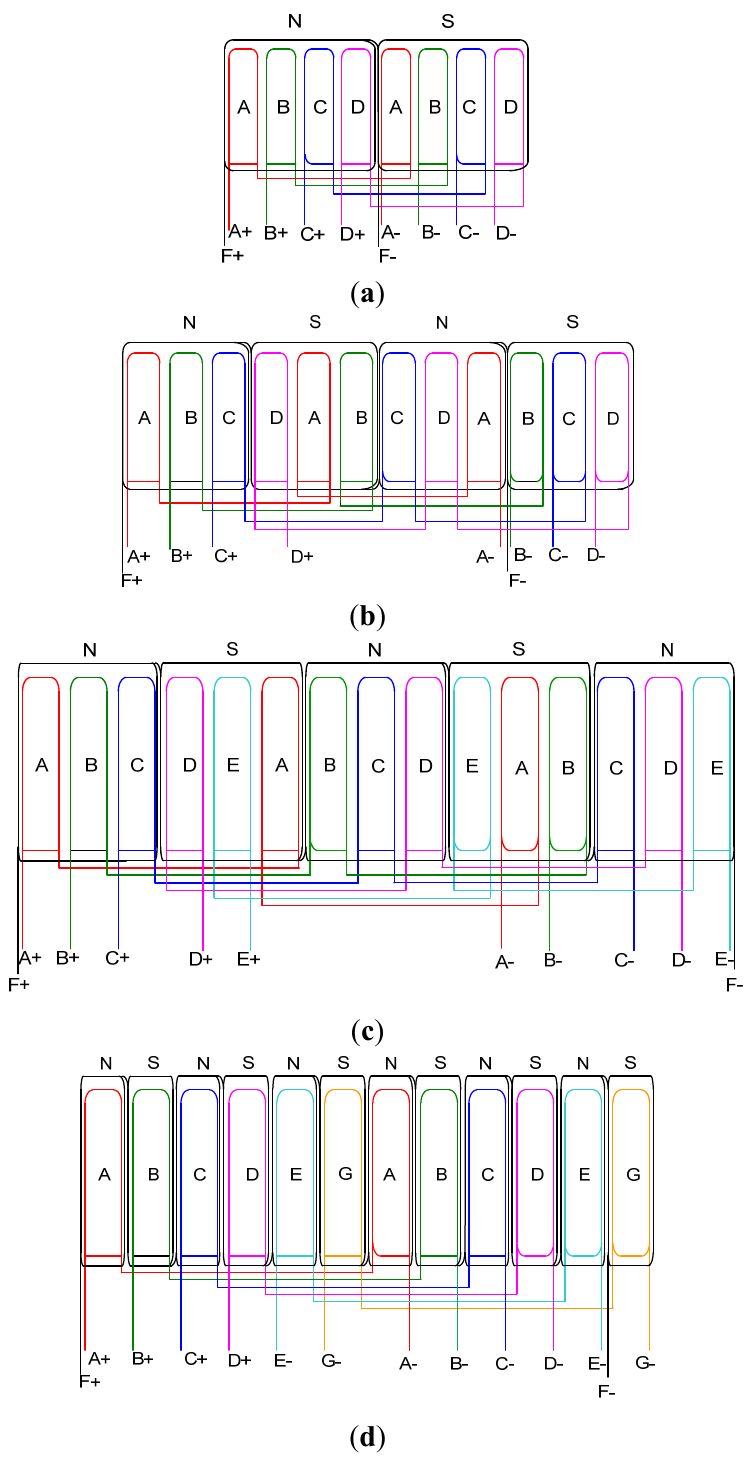
Figure 6. The connected coils of the multiphase WFDSM. ( a ) Traditional 8/6-pole four-phase; ( b ) new 12/9-pole four-phase; ( c ) 30/24-pole five-phase (half of the poles); ( d ) 12/10-pole